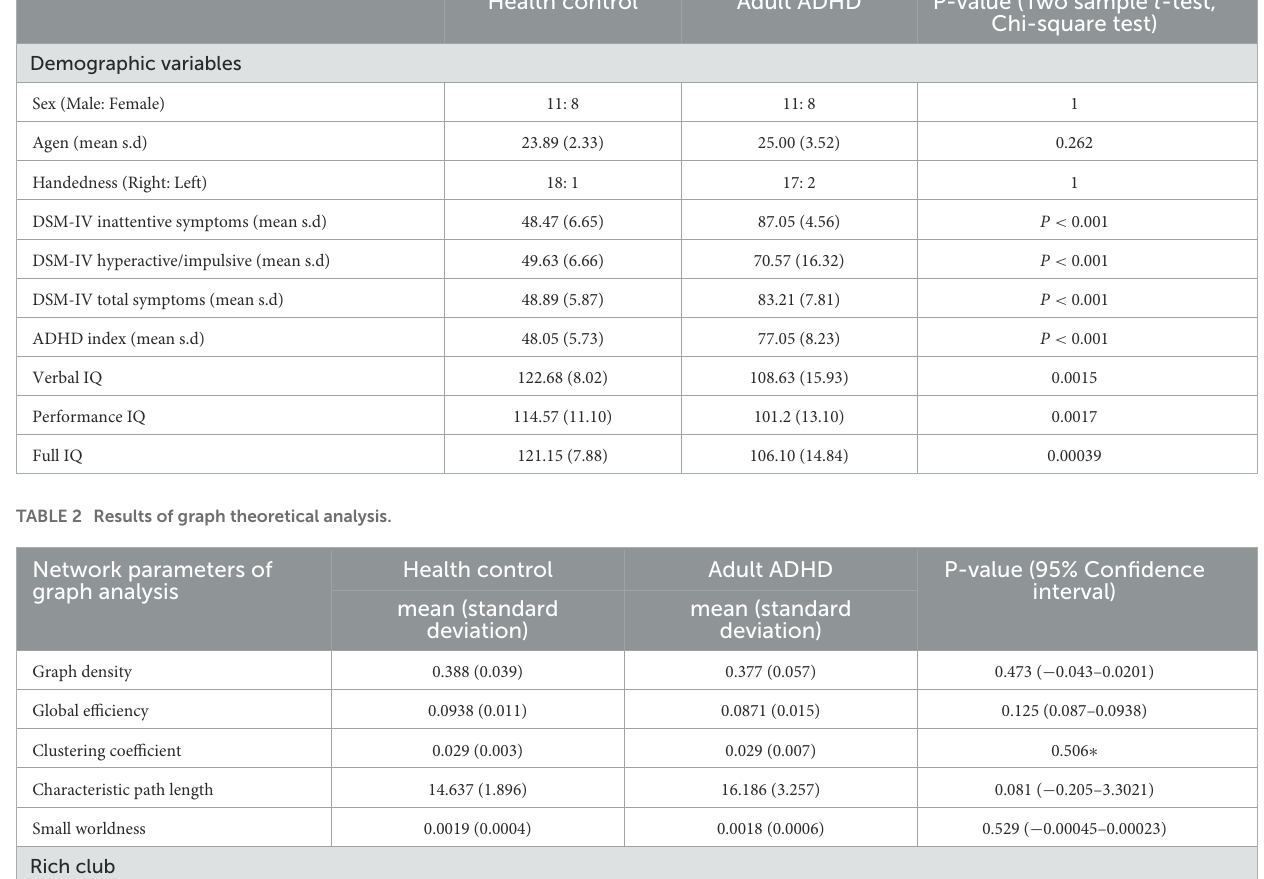
Health control Adult ADHD P-value (Two sample t -test,